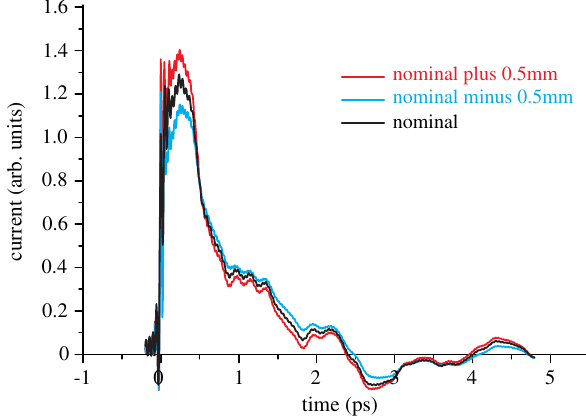
FIG. 11. The data of Fig. 7 plotted for three different values of the beam-grating separation.